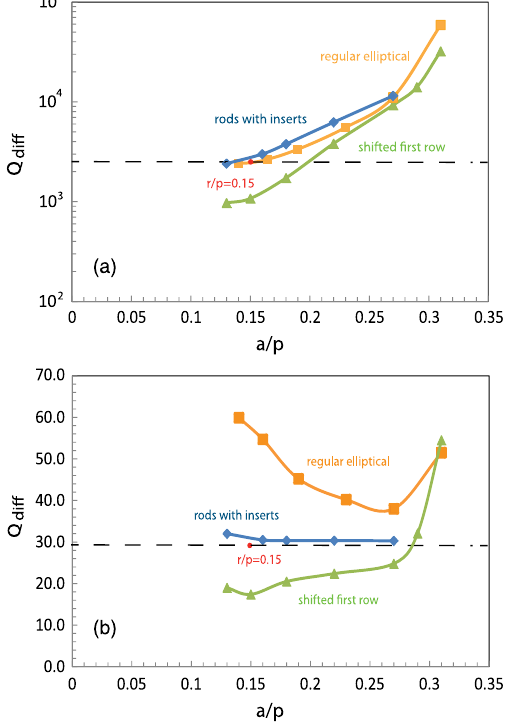
FIG. 8 (color online). A diffraction Q -factor for the funda- mental mode (a) and the higher order modes (b) in a PBG resonator made of two rows of rods as computed by the CST M ICROWAVE S TUDIO . The six central rods have elliptical shapes and the three cases correspond to elliptical rods with rectangular inserts, elliptical rods shifted to the center, and reduced period of the whole structure. For comparison also shown are the Q-factors of the fundamental mode and HOMs in a structure with equally spaced round rods and r=p ¼ 0 . 15 .